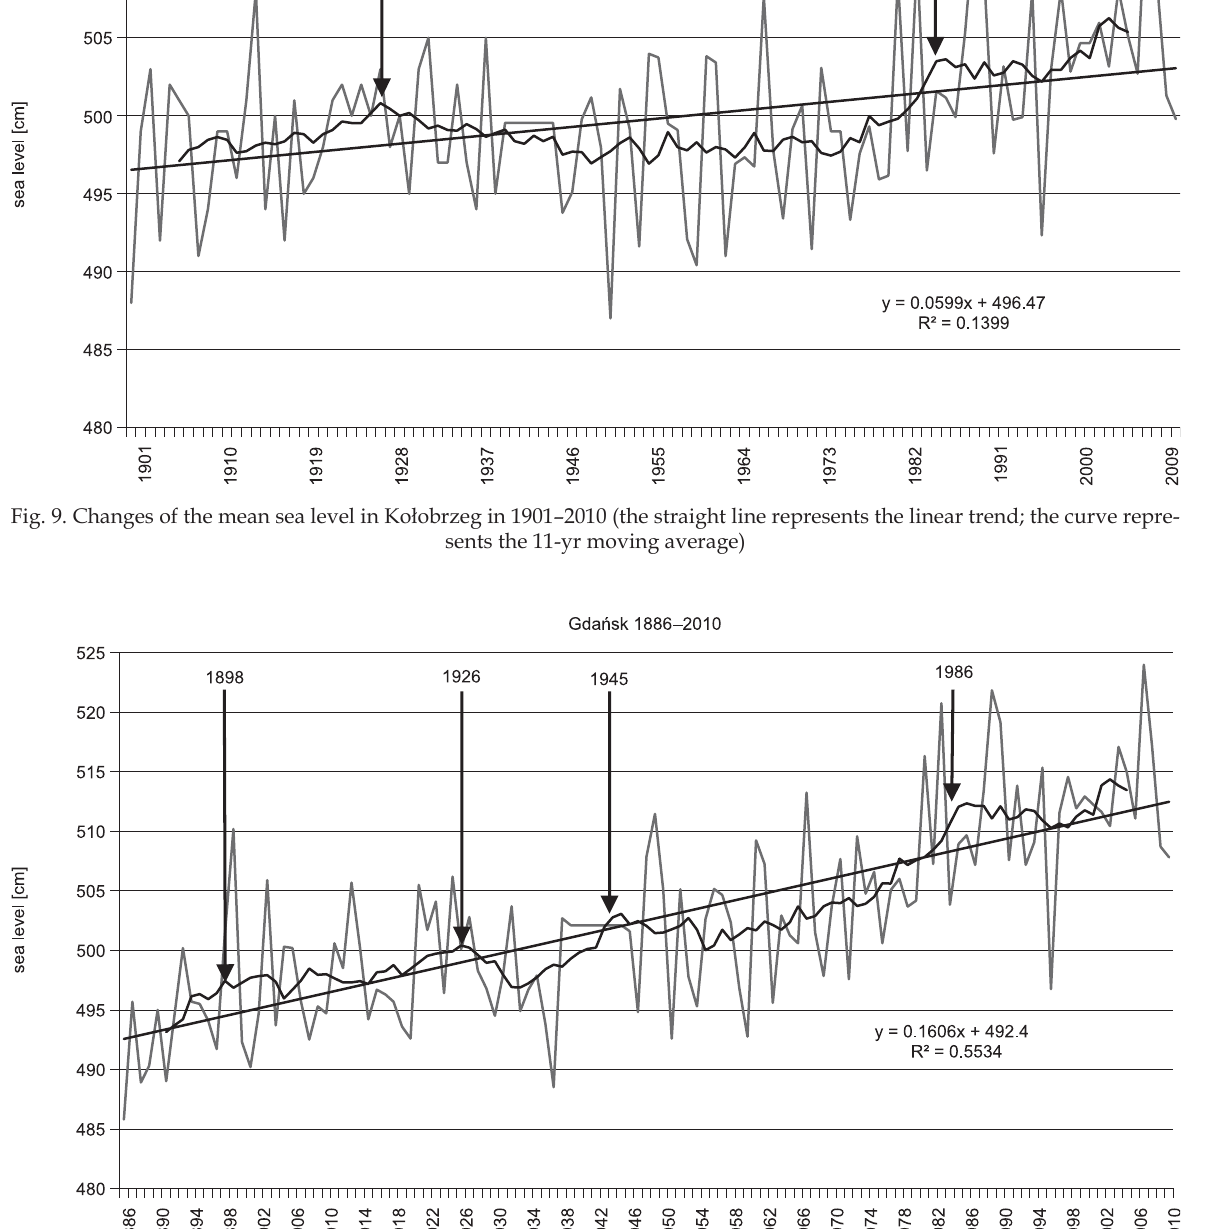
Fig. 10. Changes of the mean sea level in Gdańsk in 1886–2010 (the straight line represents the linear trend; the curve repre- sents the 11-yr moving